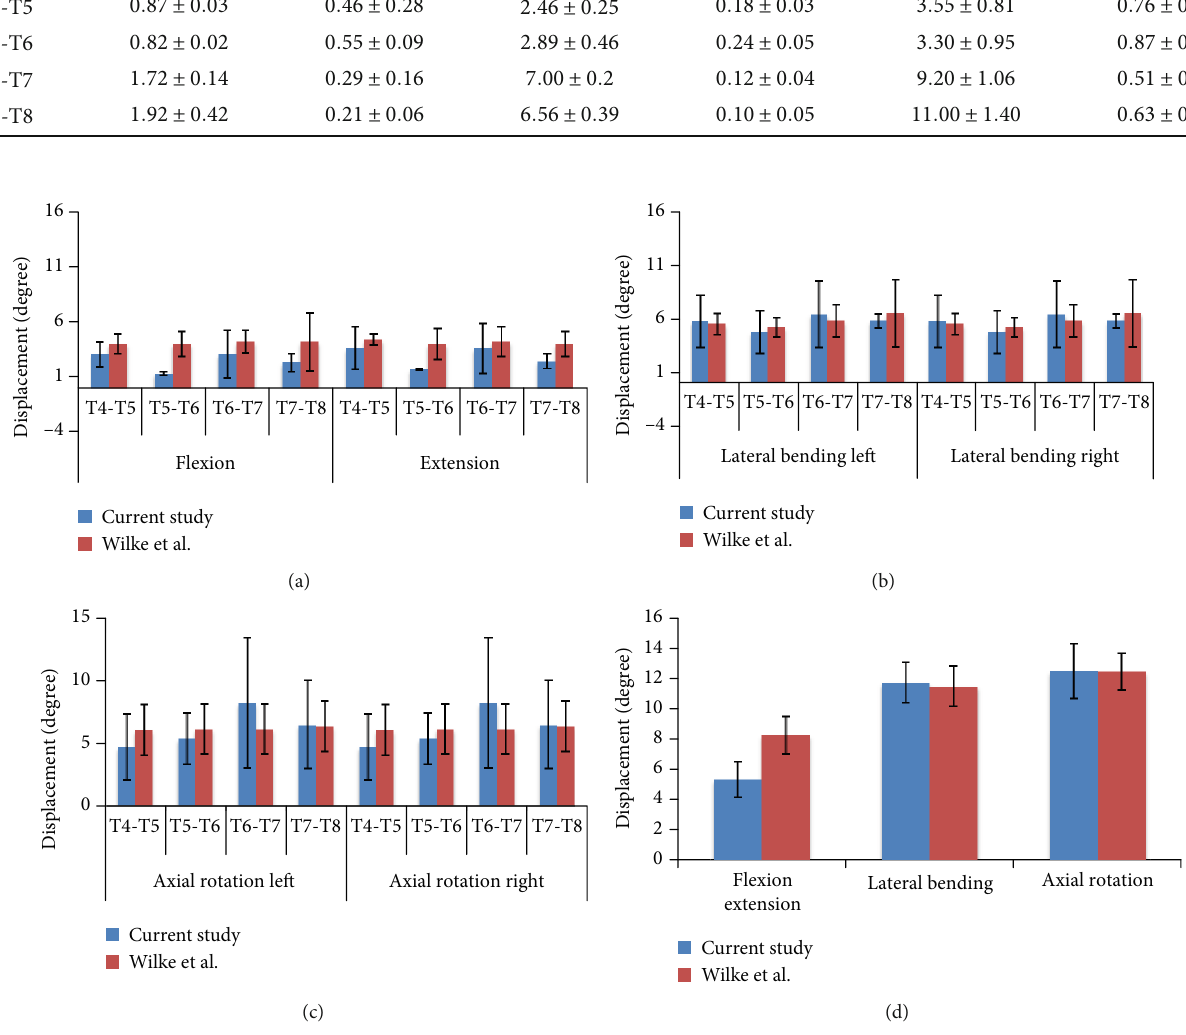
Figure 6: ROM of porcine spine between this research and Wilke et al. [2] at ± 7.5Nm moments in (a) fl exion extension, (b) lateral bending, (c) axial rotation, and (d) overall ROM.